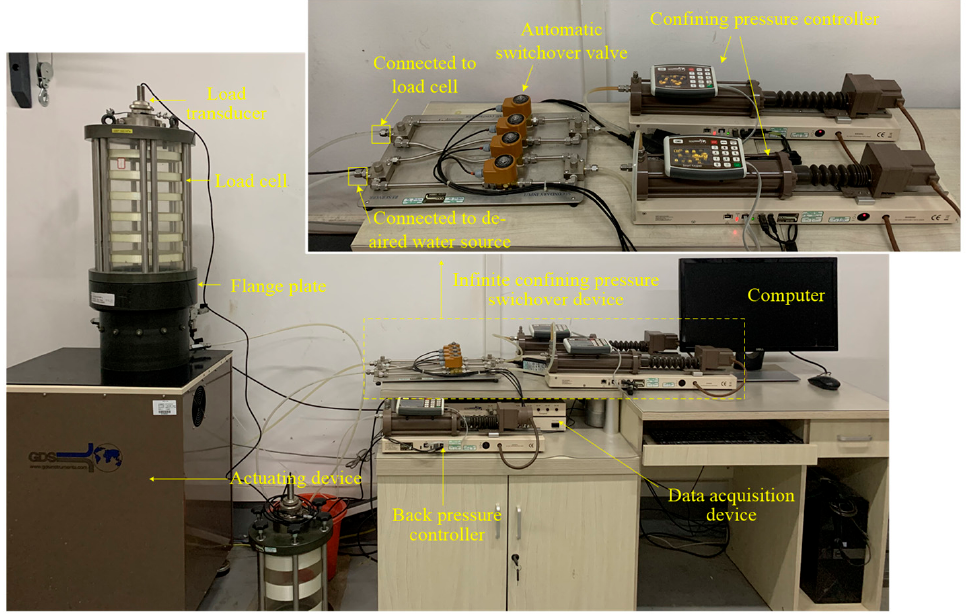
Figure 3. GDS triaxial test apparatus in this study.